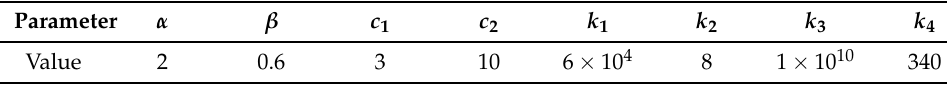
Table 1. Control Parameters of the Proposed Controller.